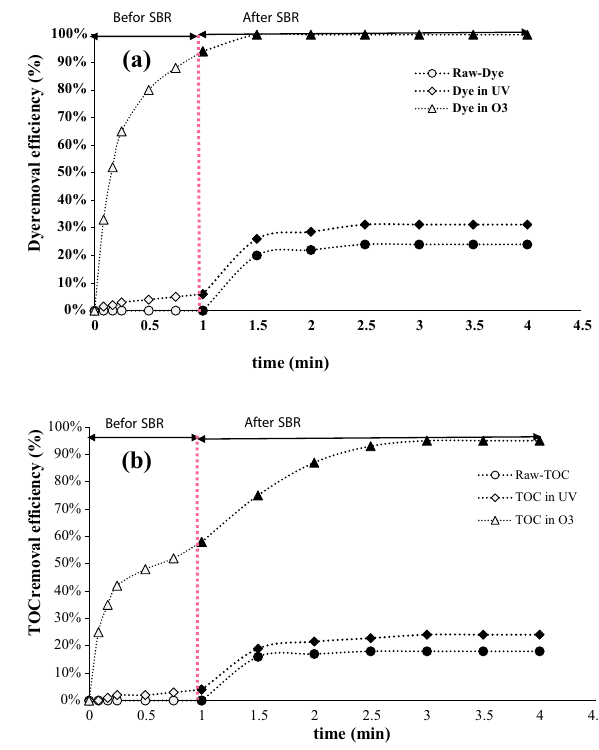
Fig. 5 The efficiency of RR-198 discoloration ( a ) and TOC removal ( b ) with ozonation pretreatment and UV-treated dye in the SBR biological process, [RR-198]: 100 mg/L, O 3 : 40 mg/L min, MLSS = 3500 mg/L